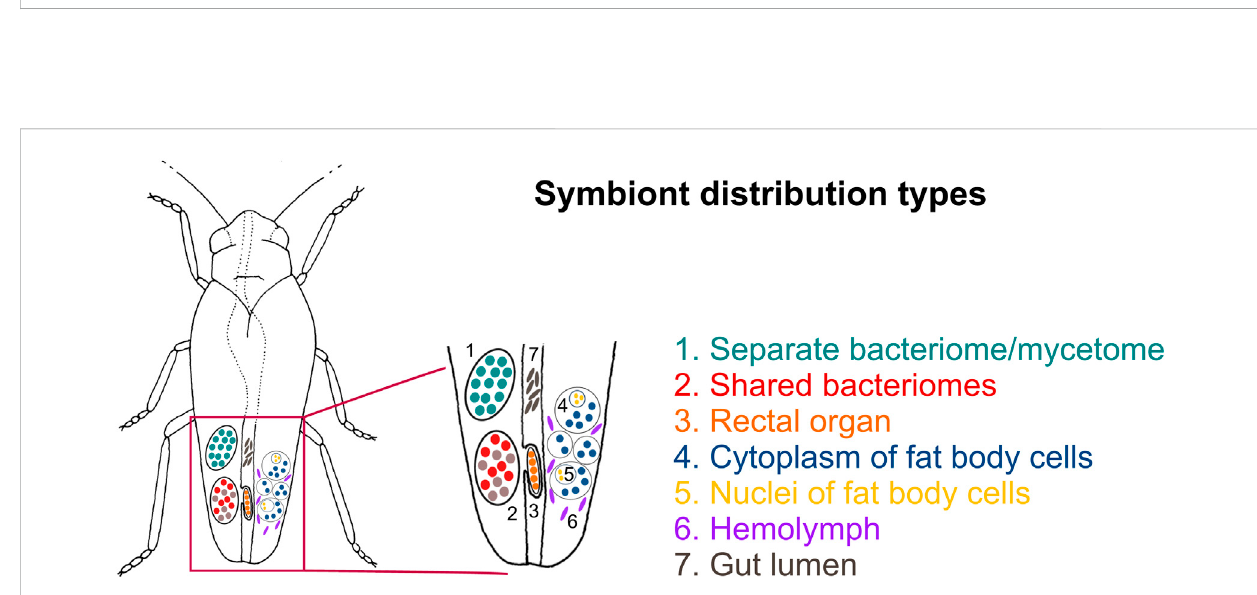
Schematic representation showing the possible symbiont localizations in the host-insect body. For a detailed description of symbiont localizations, see the main